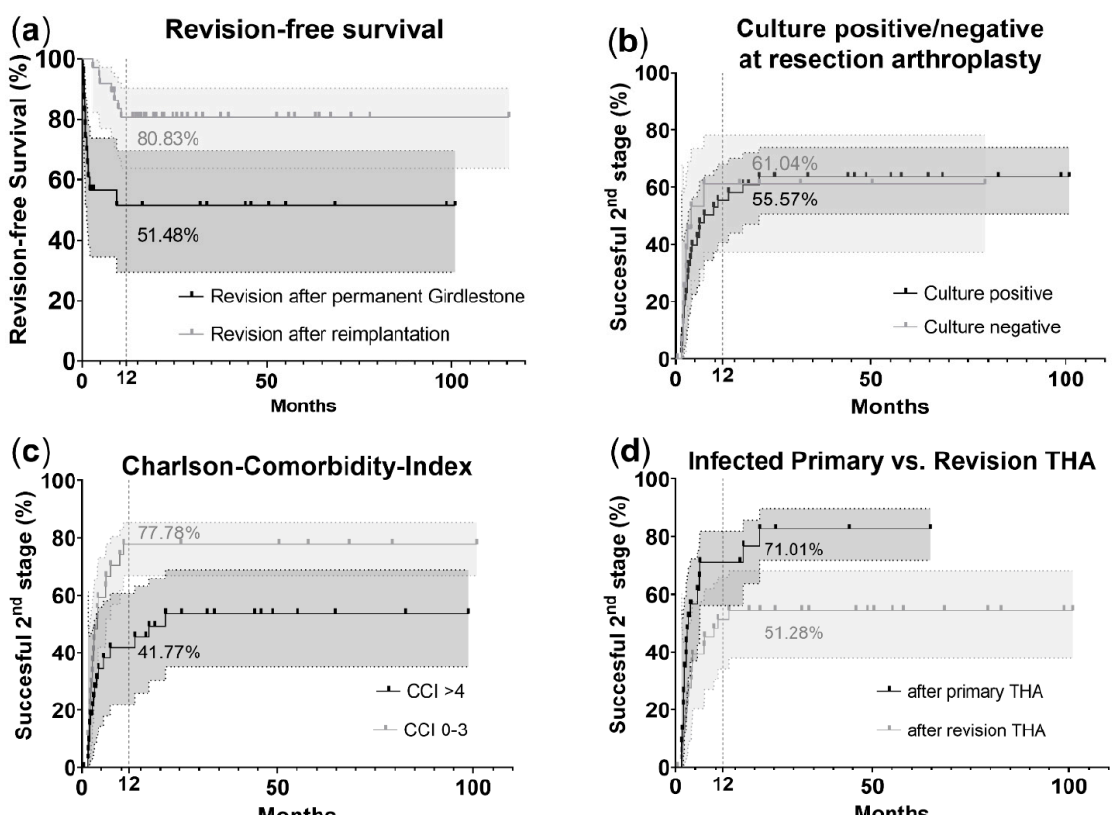
Figure 1. Kaplan–Meier curves illustrating the likelihood for ( a ) revision-free survival, ( b ) positive/negative cultures at resection arthroplasties, ( c ) Charlson comorbidity index (CCI) and ( d ) reimplantation after primary and after revision total hip arthroplasties. The Kaplan–Meier curves show plotting outcomes for two different groups in each analysis and its 95% CI interval. p values reflect the probability of a failed outcome in patients with CCI > 4 and resection arthroplasties after revision surgeries, as well as a high re-revision rate in patients with a permanent Girdlestone situation. Total hip arthroplasties